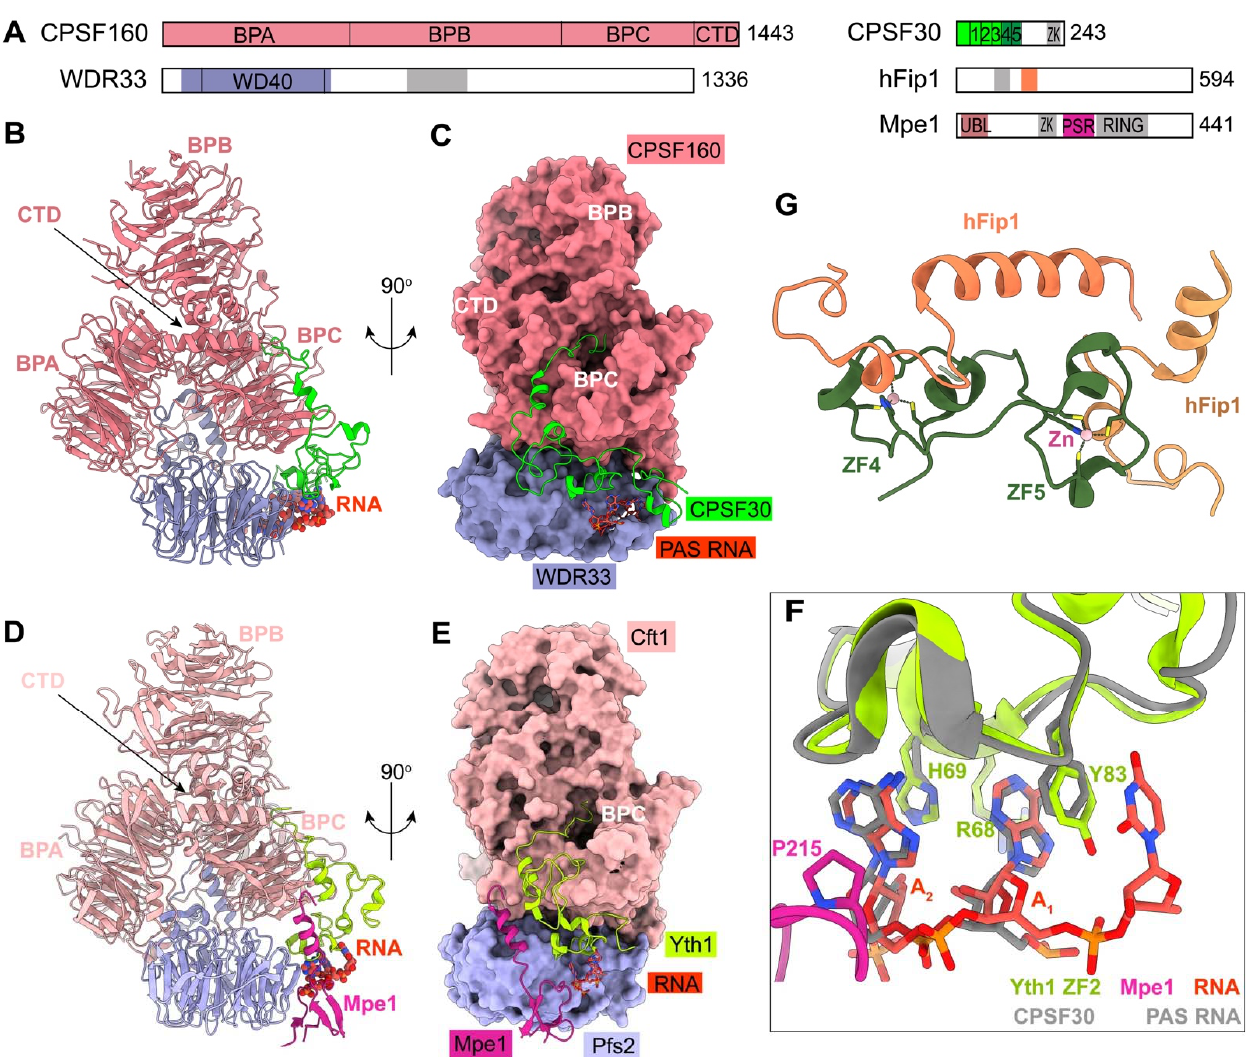
Figure 3. Molecular architecture of human mPSF and the polymerase module of yeast CPF. ( A ) Domain organizations of the subunits of mPSF, and Mpe1. The collagen-like domain in WDR33 is in gray. The zinc fingers (ZFs) of CPSF30 are in green and dark green, and the zinc knuckle in gray. The PAP-binding site of hFip1 is in gray, and the CPSF30-binding site in coral/sandy brown. The linker between CPSF30 and PAP binding sites is the central low-complexity region (LCR) in hFip1. The zinc knuckle and ring domain of yeast Mpe1 are in gray. ZK, zinc knuckle; UBL, ubiquitin-like; PSR, pre-mRNA-sensing region. ( B , C ) Structure of the human CPSF160-WDR33-CPSF30-PAS RNA complex (PDB 6DNH). The arrow points to the location of the CTD of CPSF160. The PAS RNA is shown in red orange and ball-and-stick model. The structural model in panel C is viewed after a 90 ◦ rotation around the vertical axis. The CPSF160 and WDR33 are shown as molecular surfaces. ( D , E ) Structure of the yeast Cft1-Pfs2-Yth1-Mpe1-RNA complex (PDB 7ZGP). The domains in the yeast polymerase module are given lighter colors compared to their homologs in human mPSF. The PSR domain of Mpe1 interacts directly with the polymerase module. ( F ) Comparison of the recognition mechanism of A1A2 in the human mPSF (in gray) and yeast polymerase module-Mpe1 complex (in color). The residue P215 of yeast Mpe1 directly contacts with A2. ( G ) Structure of the human CPSF30-hFip1 complex. The ZF4 and ZF5 of CPSF30 are in dark green. The two hFip1 molecules are in coral and sandy brown. Structure figures are produced with ChimeraX [50]. In contrast, PAS in yeast, also known as the positioning element, is highly degenerate and less well defined with A-rich sequences [51]. The molecular details of recognition